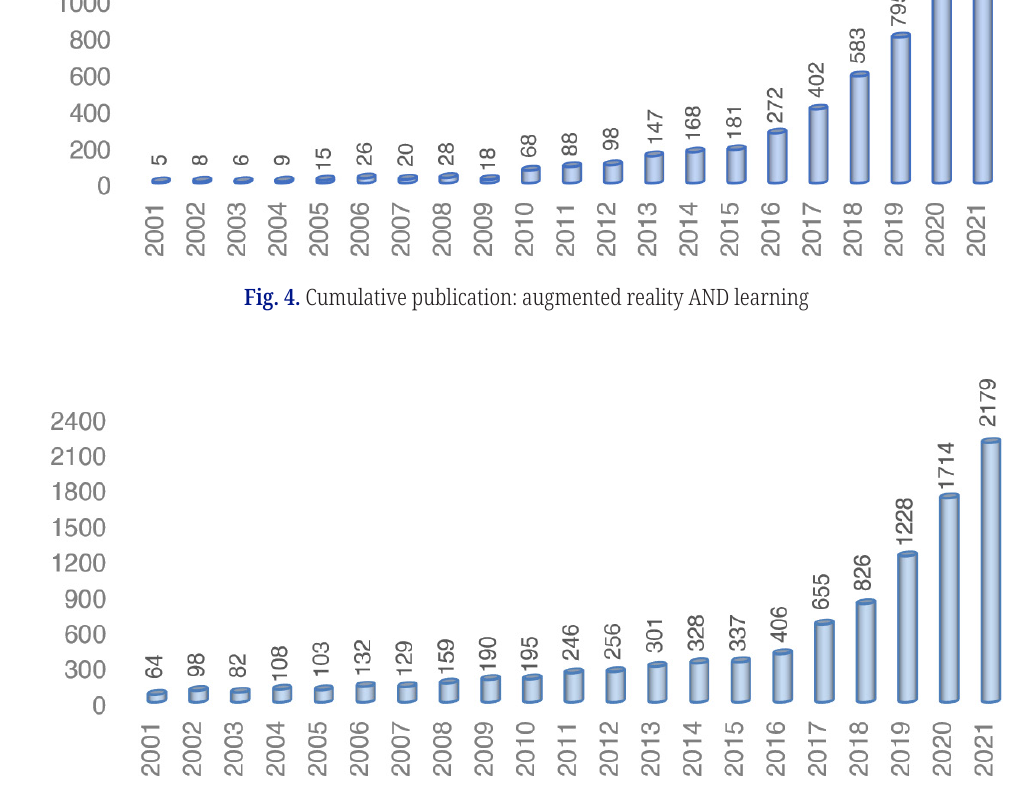
Fig. 5. Cumulative publication: virtual reality AND